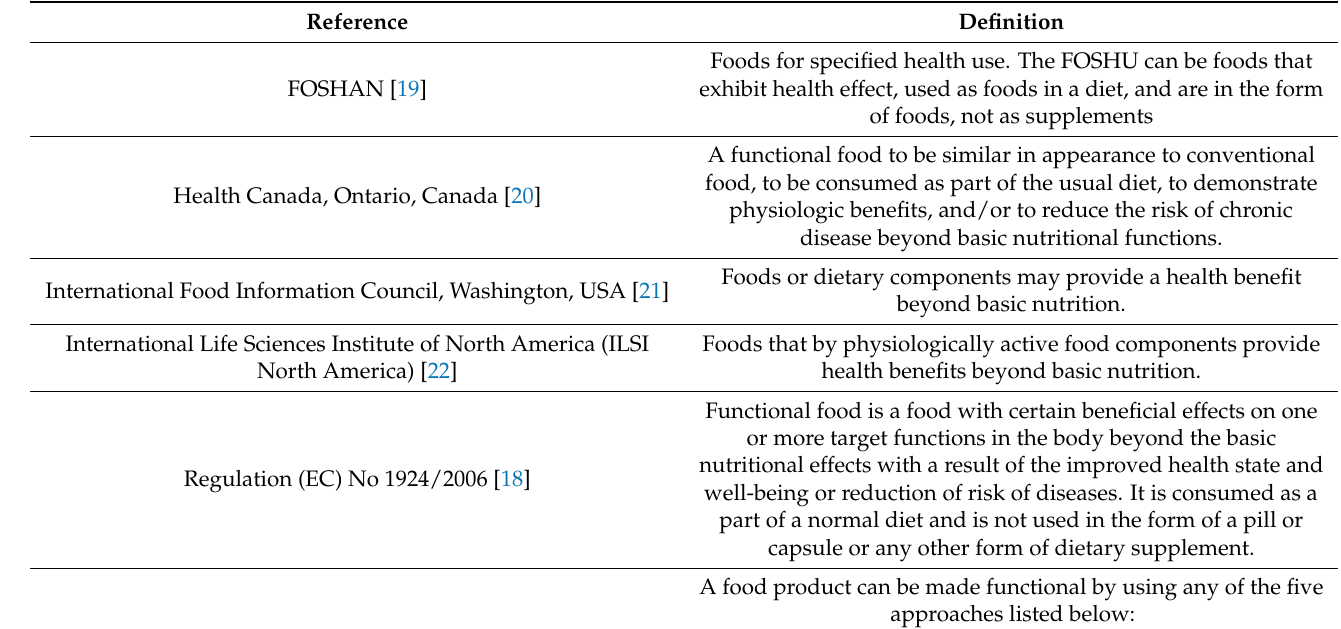
Table 3. Several definitions of functional